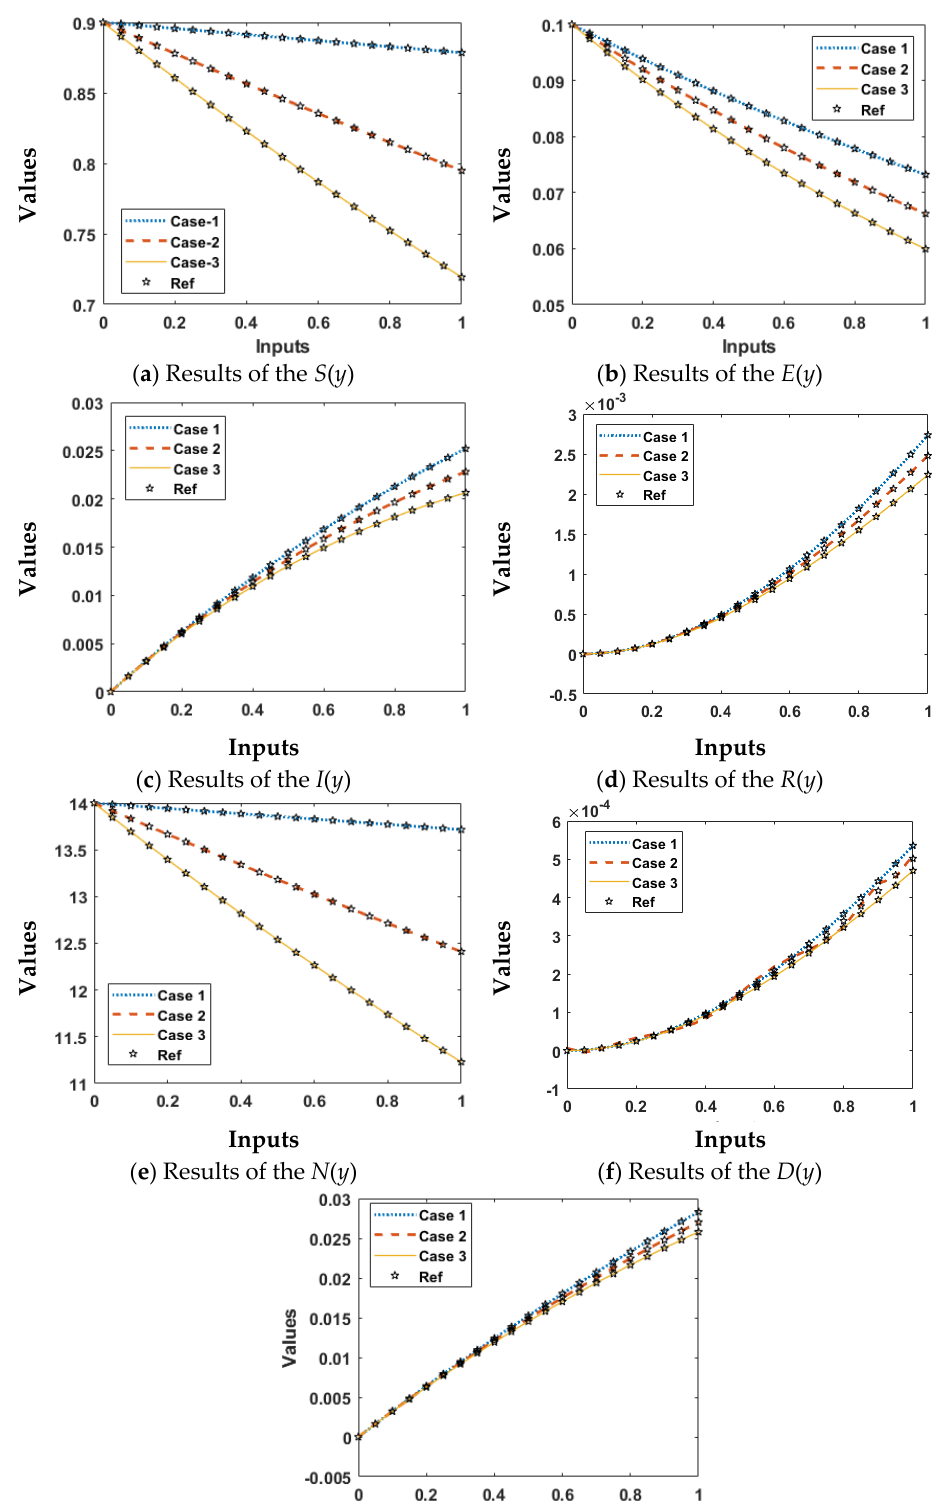
Figure 9. Result comparisons using the ANNs-LMB to solve the nonlinear COVID-19 spreading model.